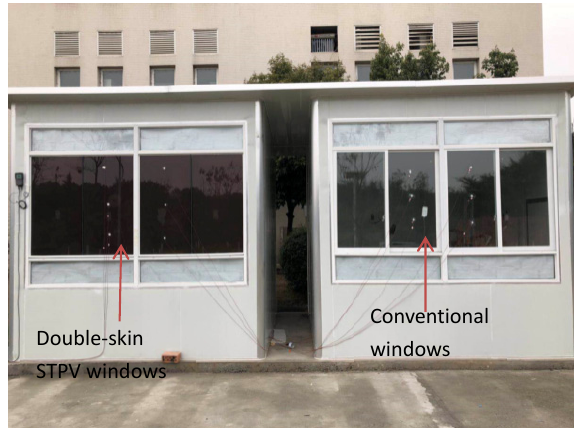
Figure 2. Test rig. Figure 2. Test rig.